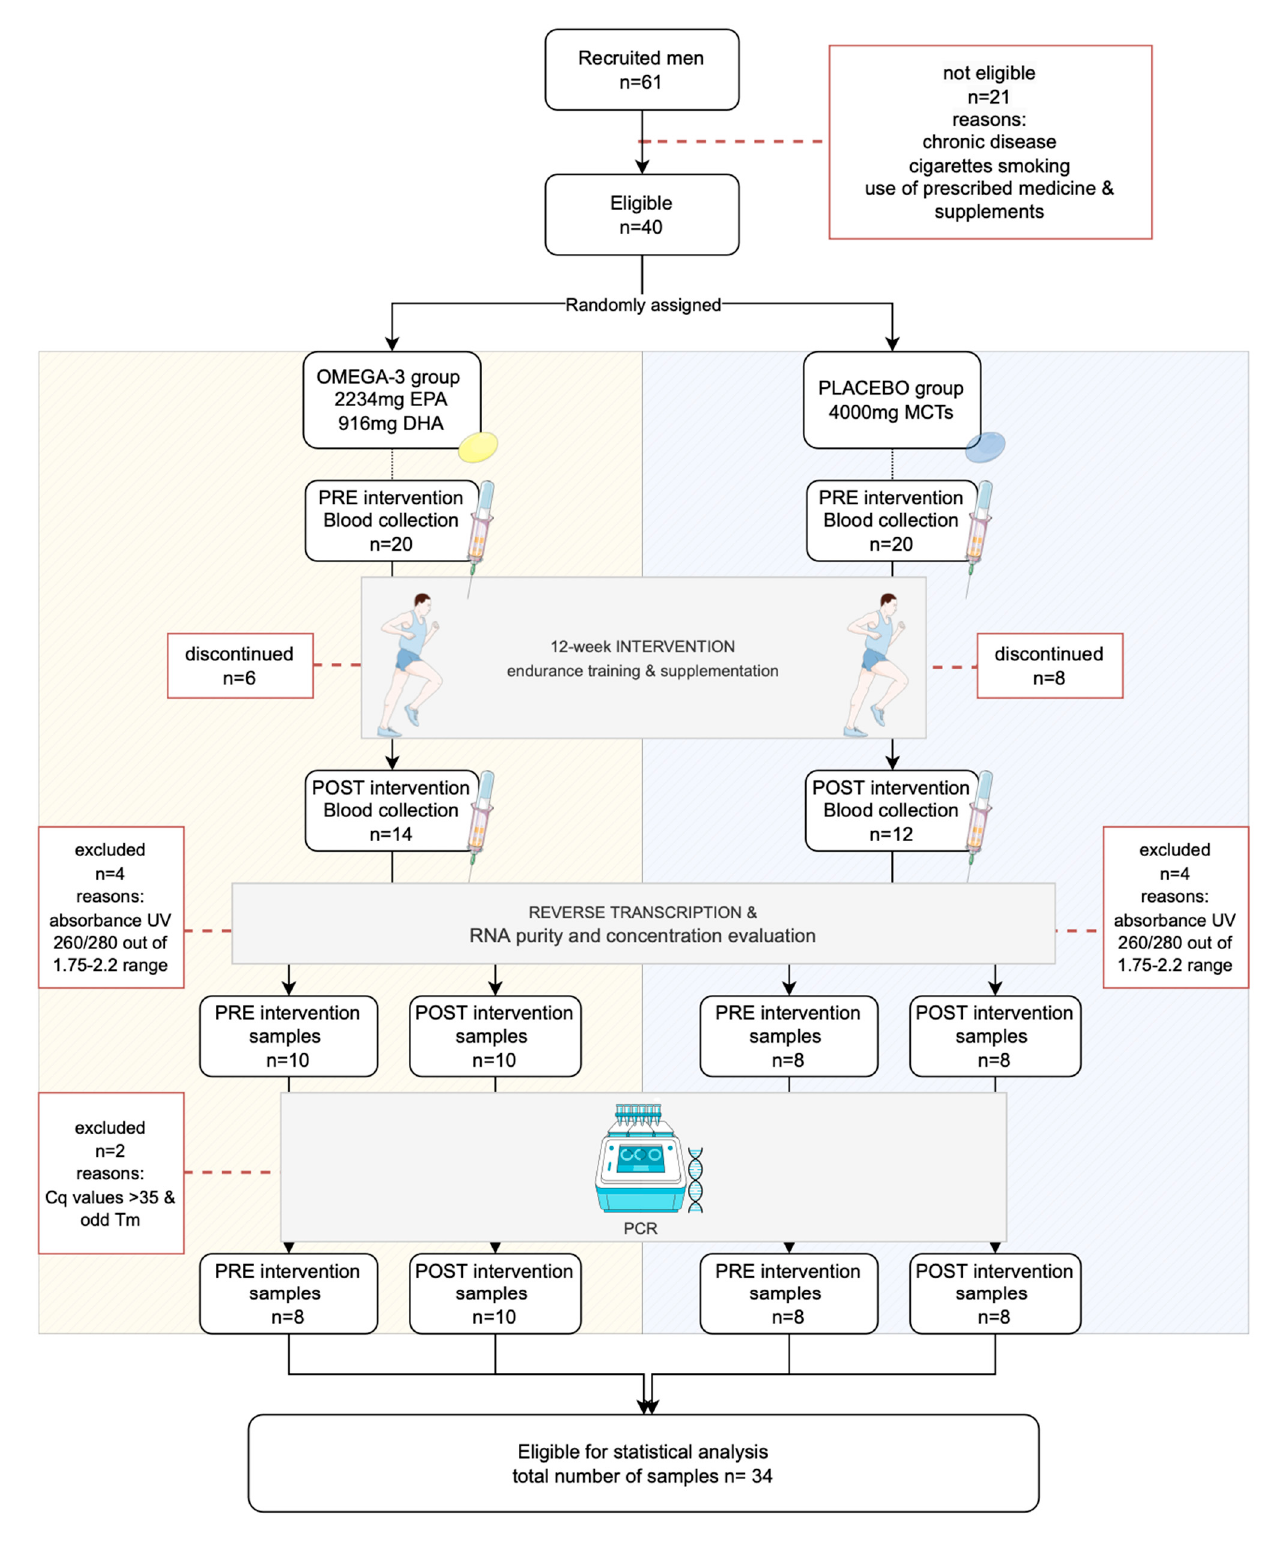
Figure 3. Flow diagram of the study process and group sizes.